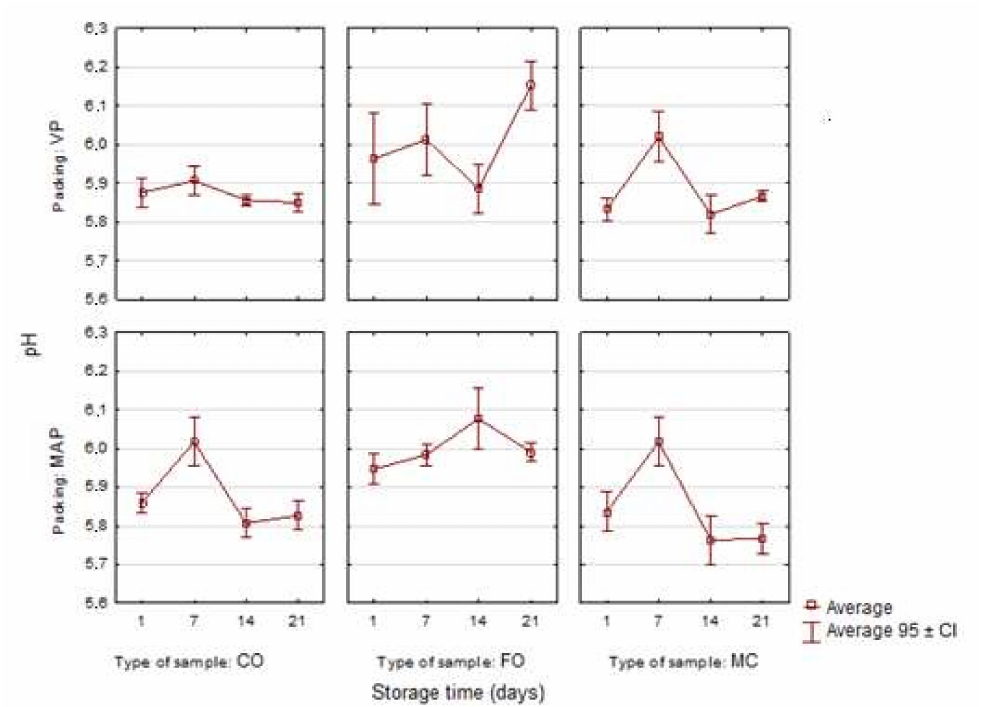
Figure 1. Changes in the pH value in the poultry sausages depending on the type of sample, packing and storage time ( n =